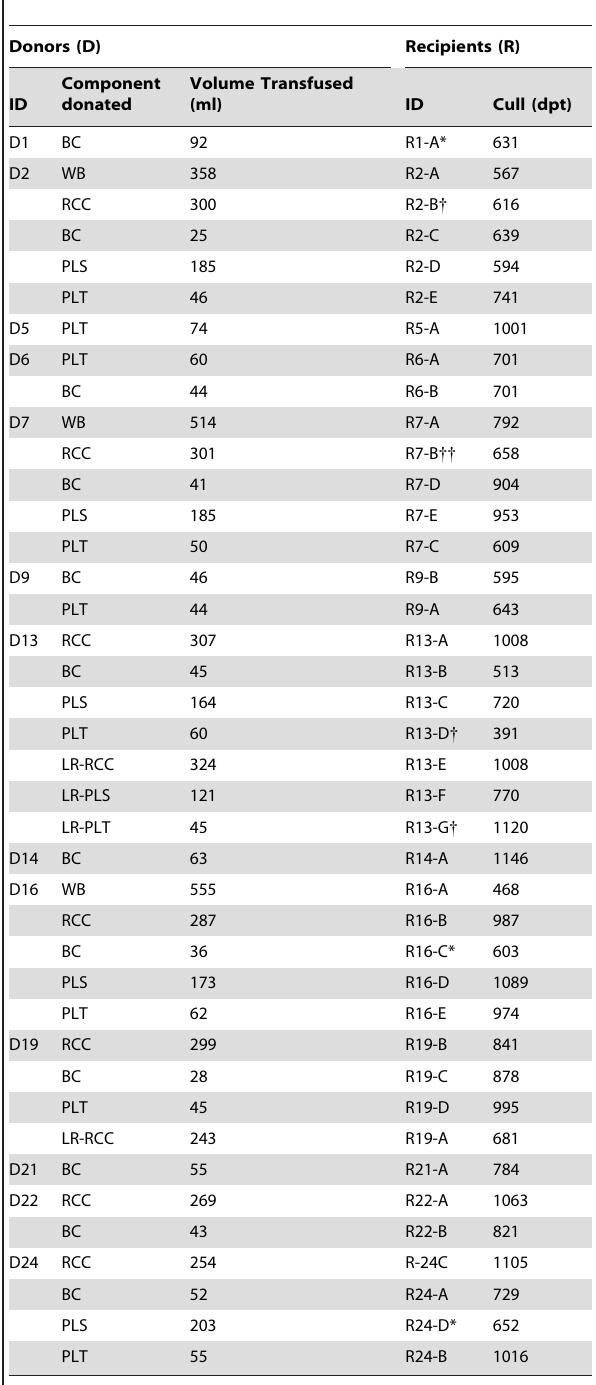
Table 1. Summary of BSE transmissions in recipients following blood transfusion.